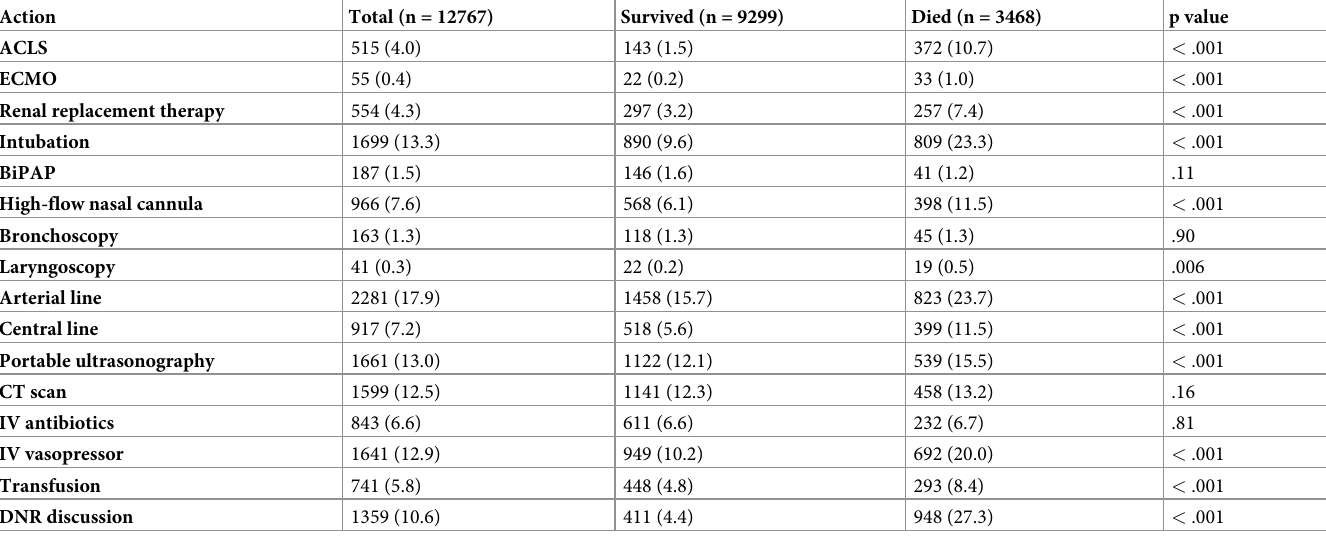
Table 3. Medical emergency team interventions.